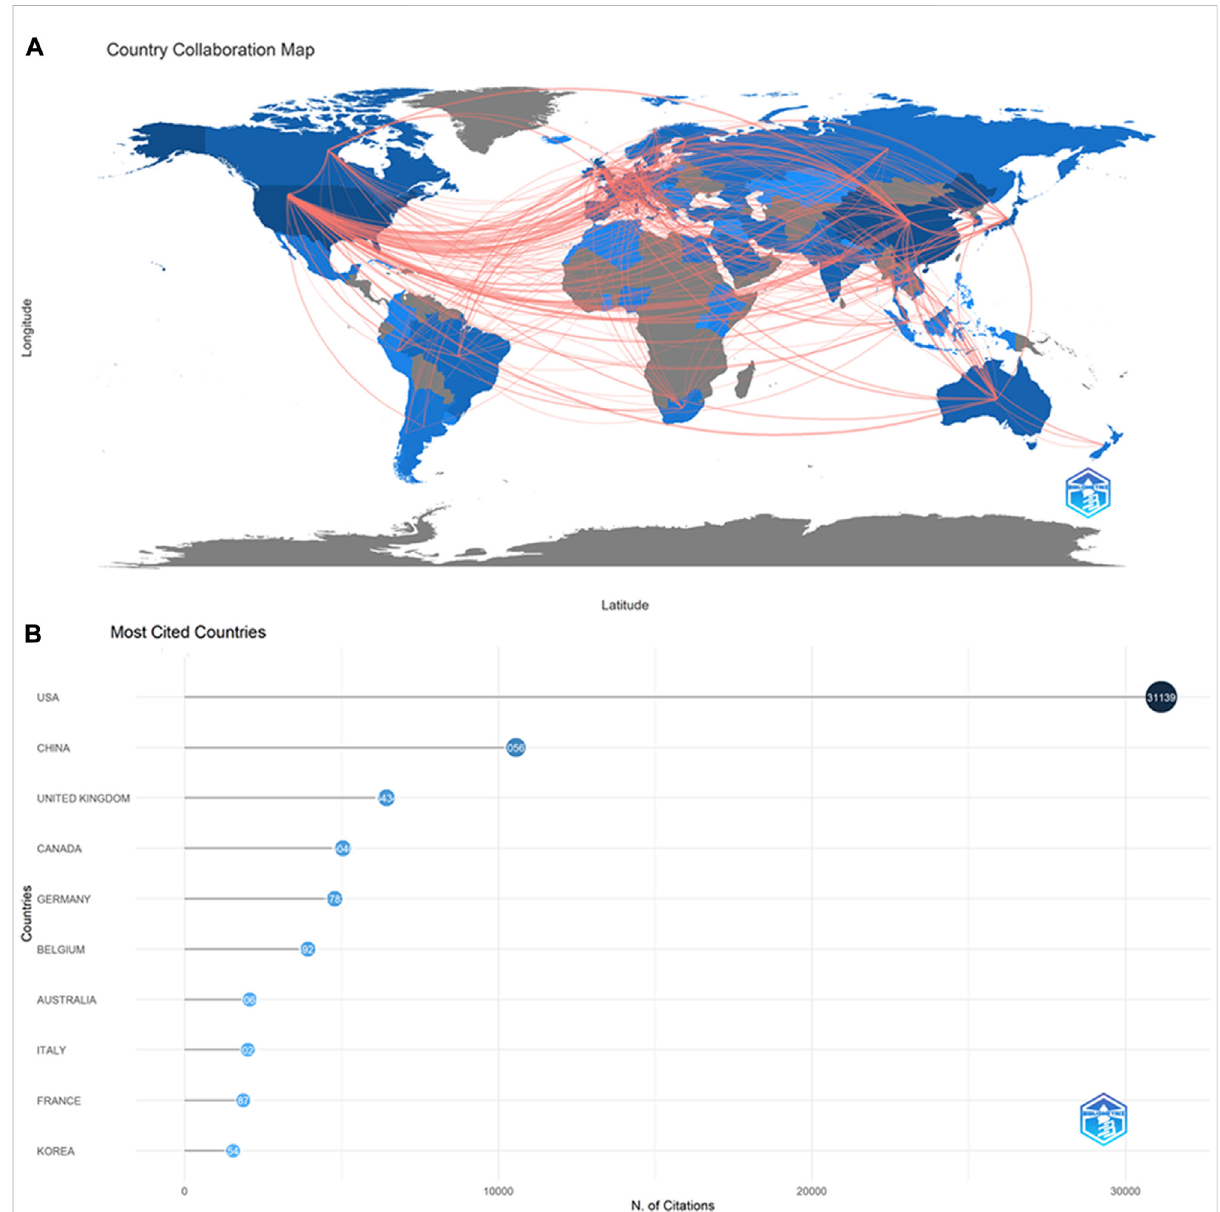
FIGURE 3 The cooperation of countries/regions contributed to publications. (A) Country Collaboration map. (B) Most Cited Countries.